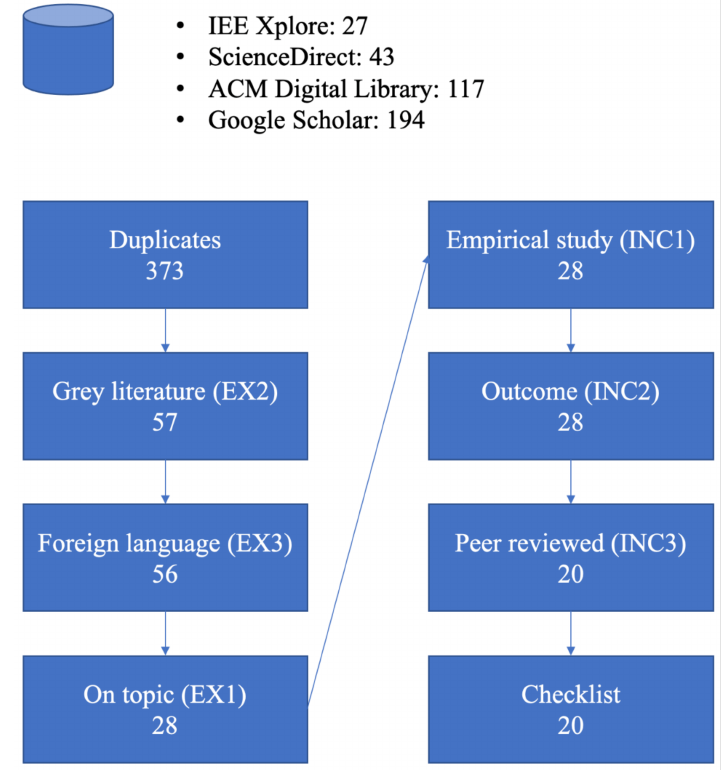
Figure 2. Attrition of papers at different processing stages.